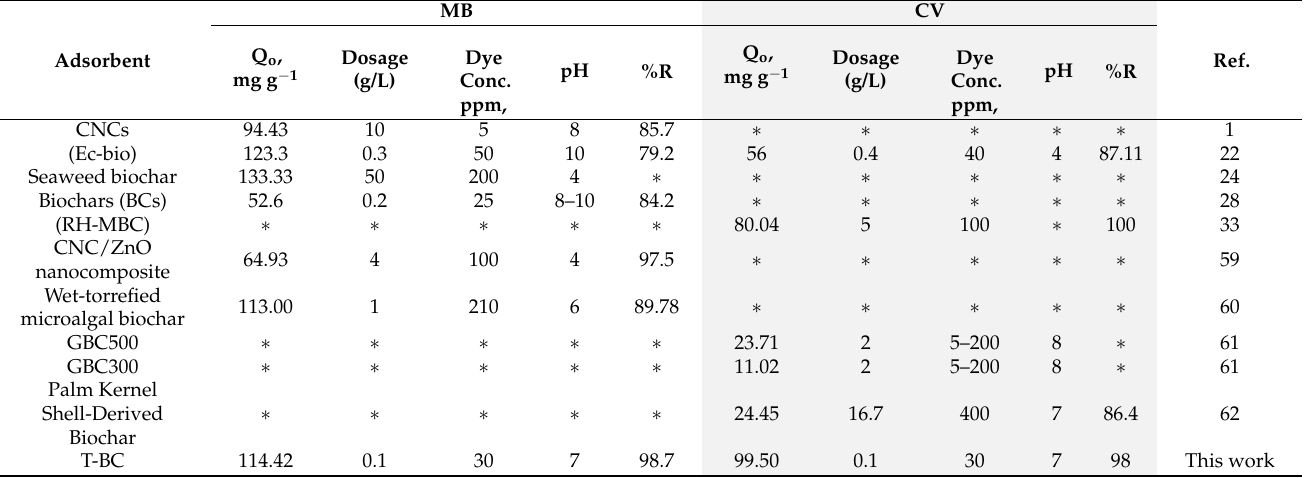
Table 5. Comparison of various adsorbents to adsorb MB and CV-dyes from aqueous